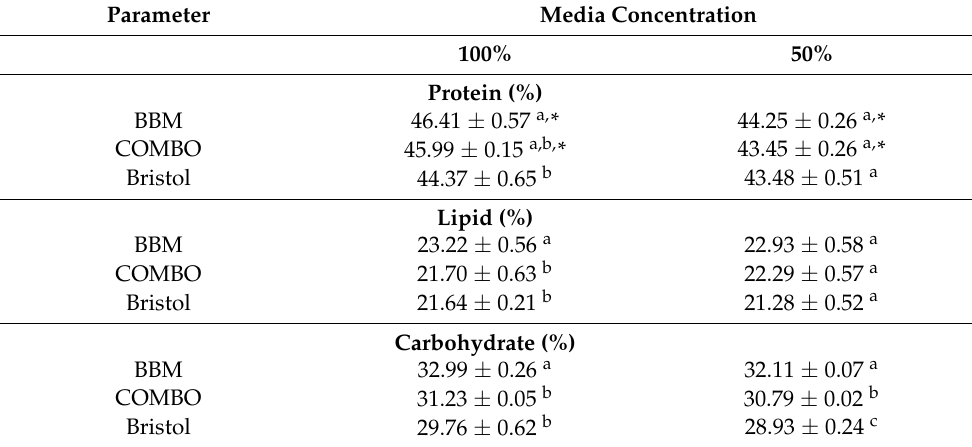
Table 3. Proximate composition of Ankistrodesmus falcatus cultured in different media. Numbers are means ± standard errors. a–c Value under the same parameter represents the mean samples with a significant difference between culture media ( p ≤ 0.05). * Value under the same parameter represents the mean samples with a significant difference between concentrations ( p ≤